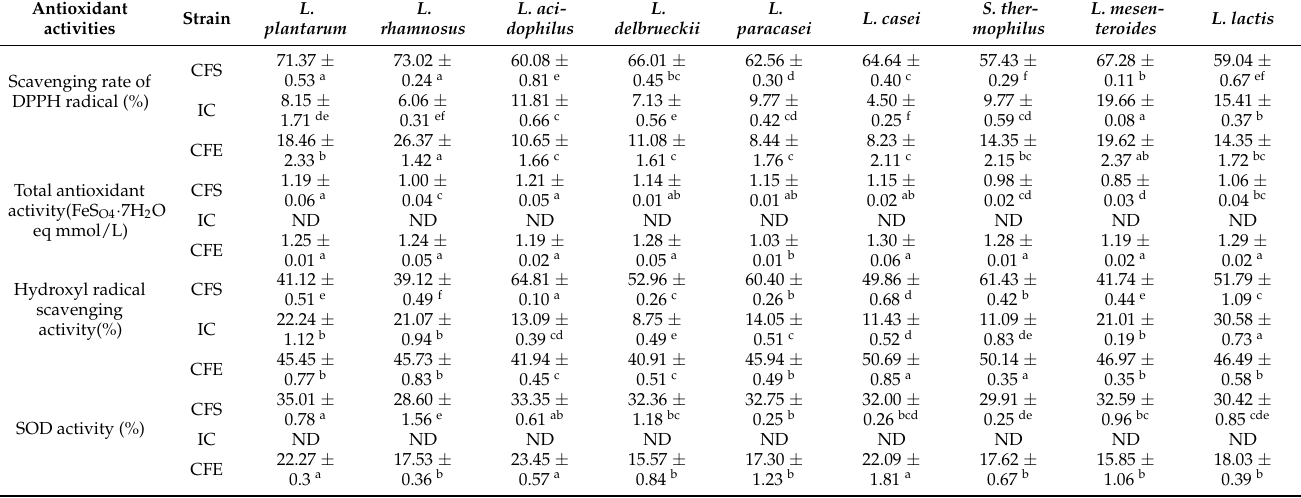
Table 2. Antioxidant activities of